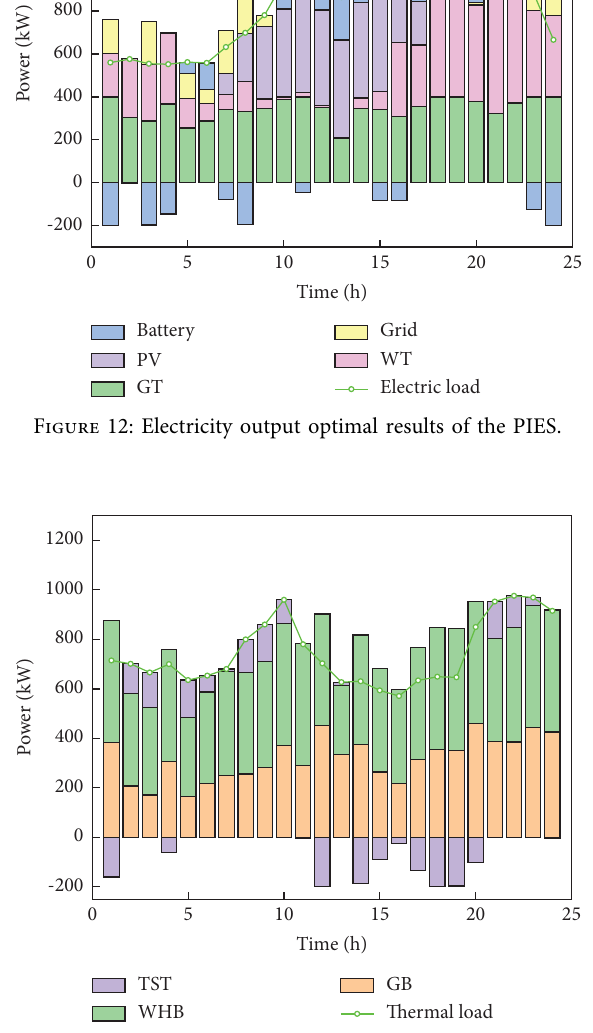
Figure 11: Te electric and heat load curves before and after optimization.